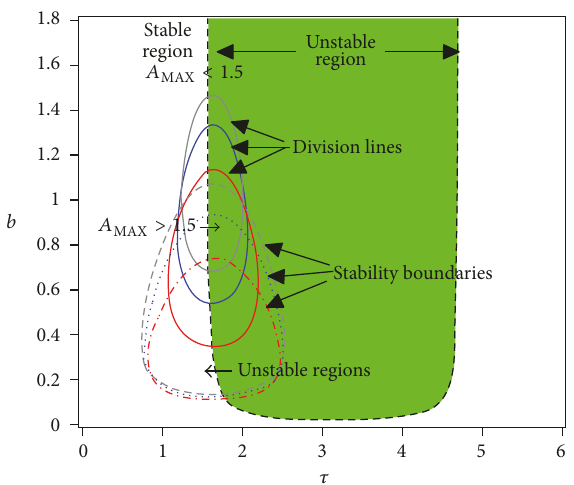
Figure 8: Design illustration of feedback gain and time delay.